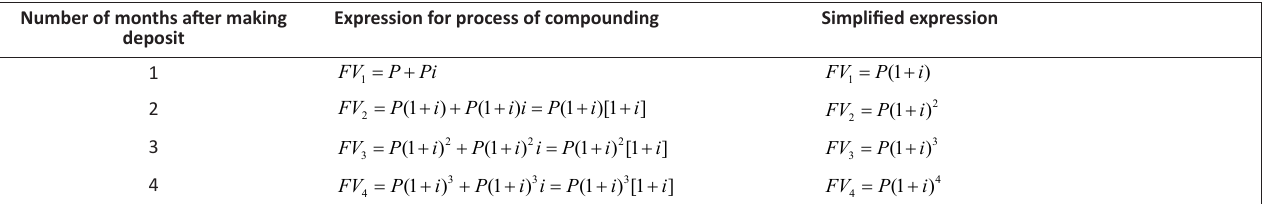
FIGURE 5: Compounding of single payment.